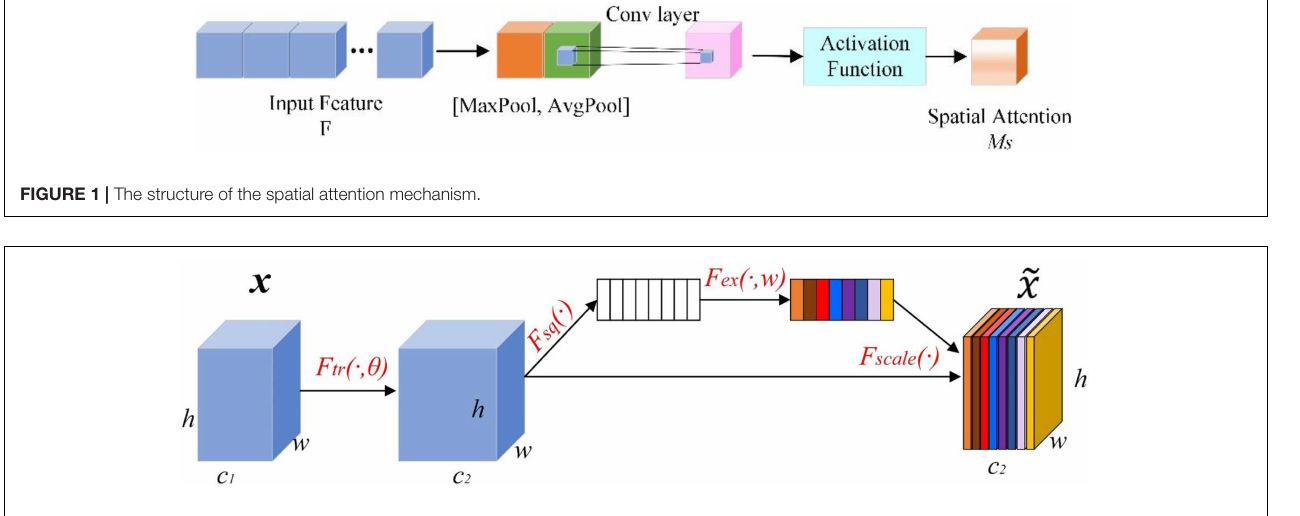
FIGURE 2 | The structure of the channel attention mechanism.